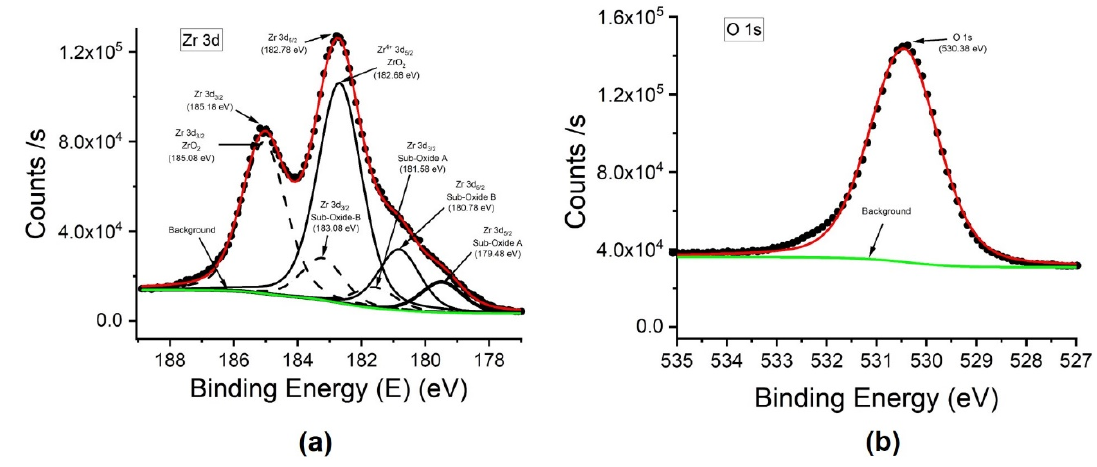
Figure 4. ( a ) High-resolution XPS scan of the Zr 3d in the ZrO 2 film; ( b ) High-resolution XPS scan of the O 1s in the ZrO 2 film.